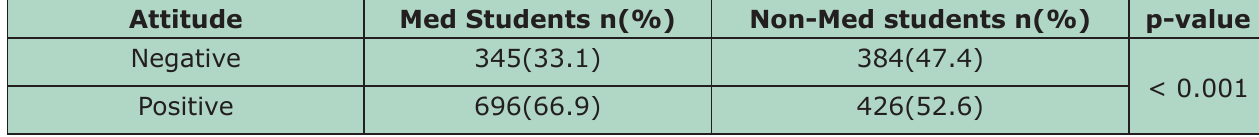
Table-III: Comparison of attitudes of medical and non-medical students about